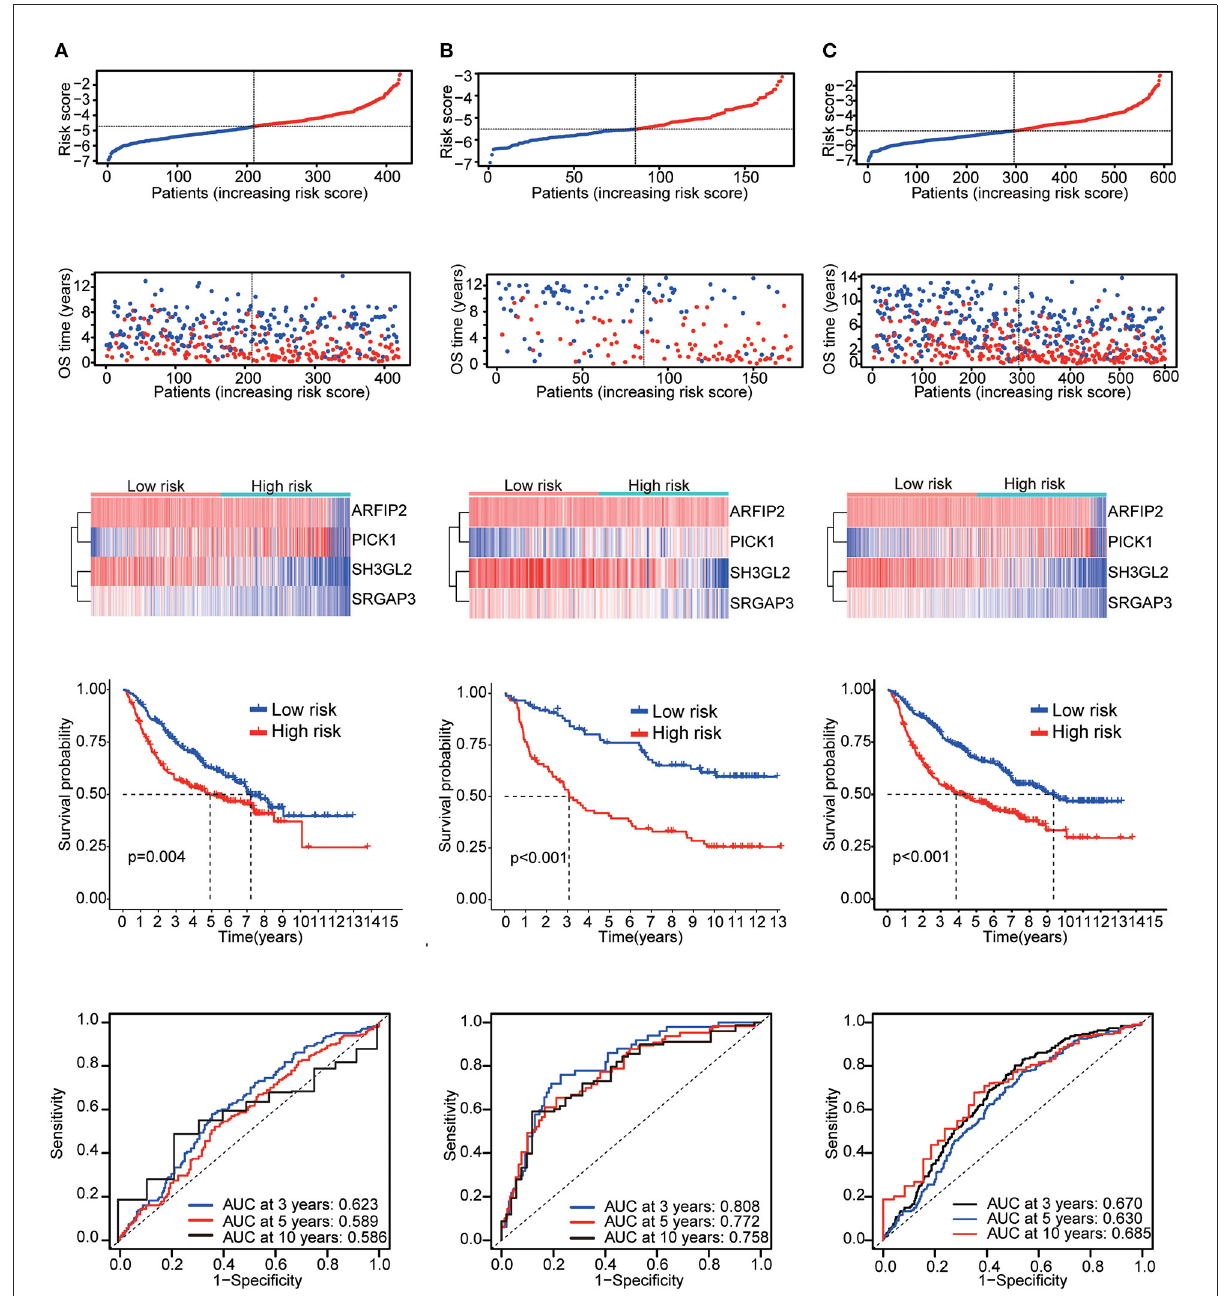
FIGURE4 Validation results (A) CGGA mRNA-seq_693 cohort. (B) CGGA mRNAseq_325 cohort. (C) Whole CGGA mRNAseq